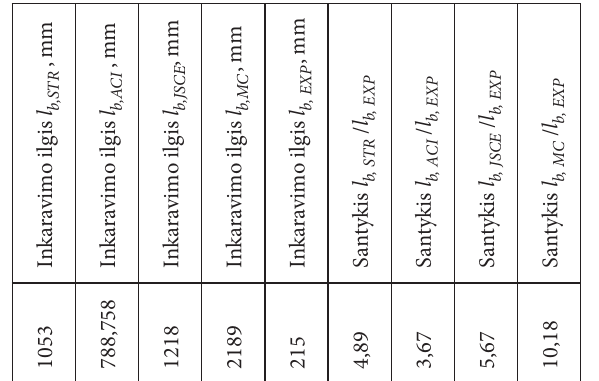
Table 2. A comparison of experimental and theoretical results of anchorage length